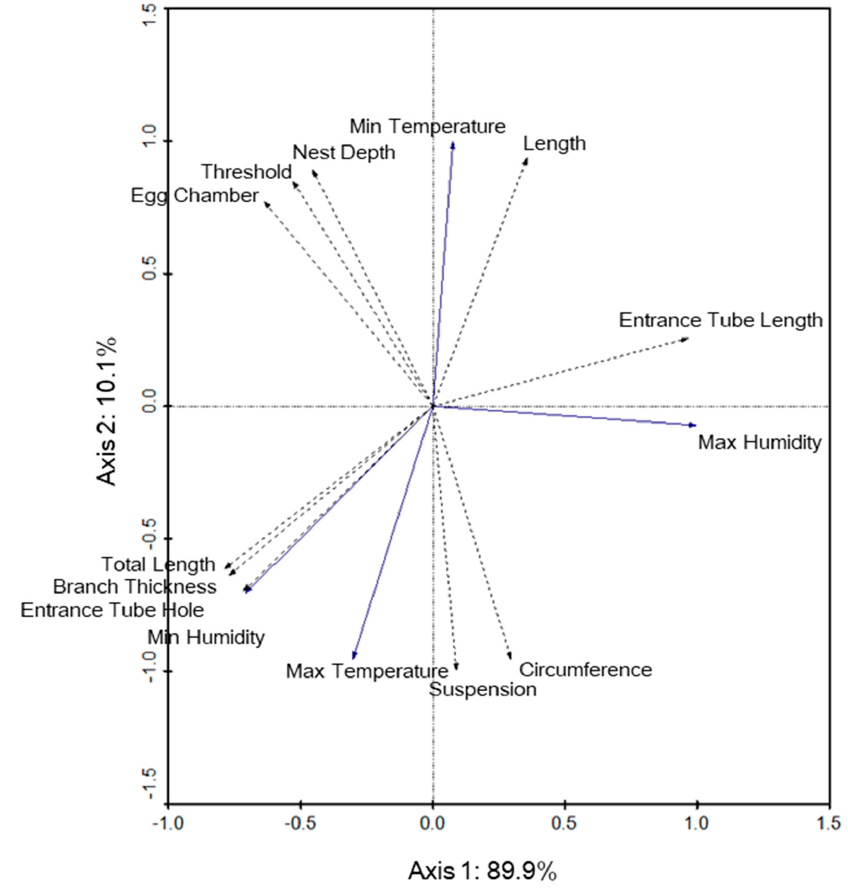
Figure 8. Redundancy analysis biplot of microclimate within the baya weaver ( Ploceus philippinus ) nests (solid line vectors) and nest structure variables (dotted line vectors) for the Perlis site. The arrows indicate the direction that the nest structure increased in measurement whereas the angles between variables approximate their correlations. Table 3. Strength of correlations and their significance levels based on Spearman’s correlation analysis between macroclimate and microclimate factors at Selangor site.